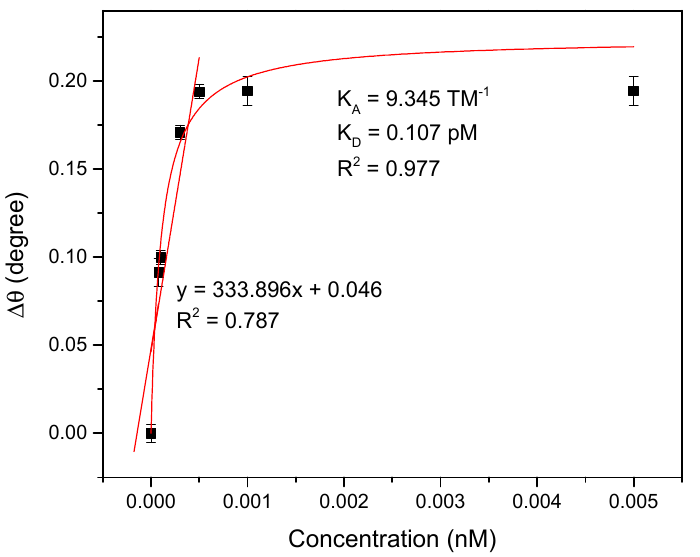
Figure 5. A linear regression graph and Langmuir graph for Au/DSU/NH 2 rGO–PAMAM/IgM sensor film.